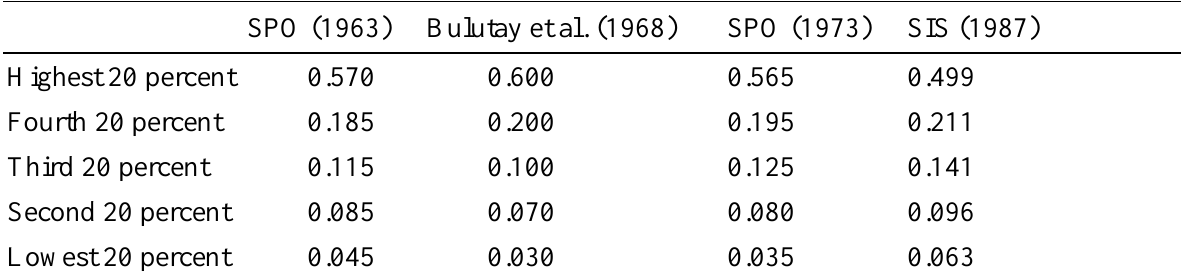
Table 1. Size of Distribution of National Income In Turkey (% of